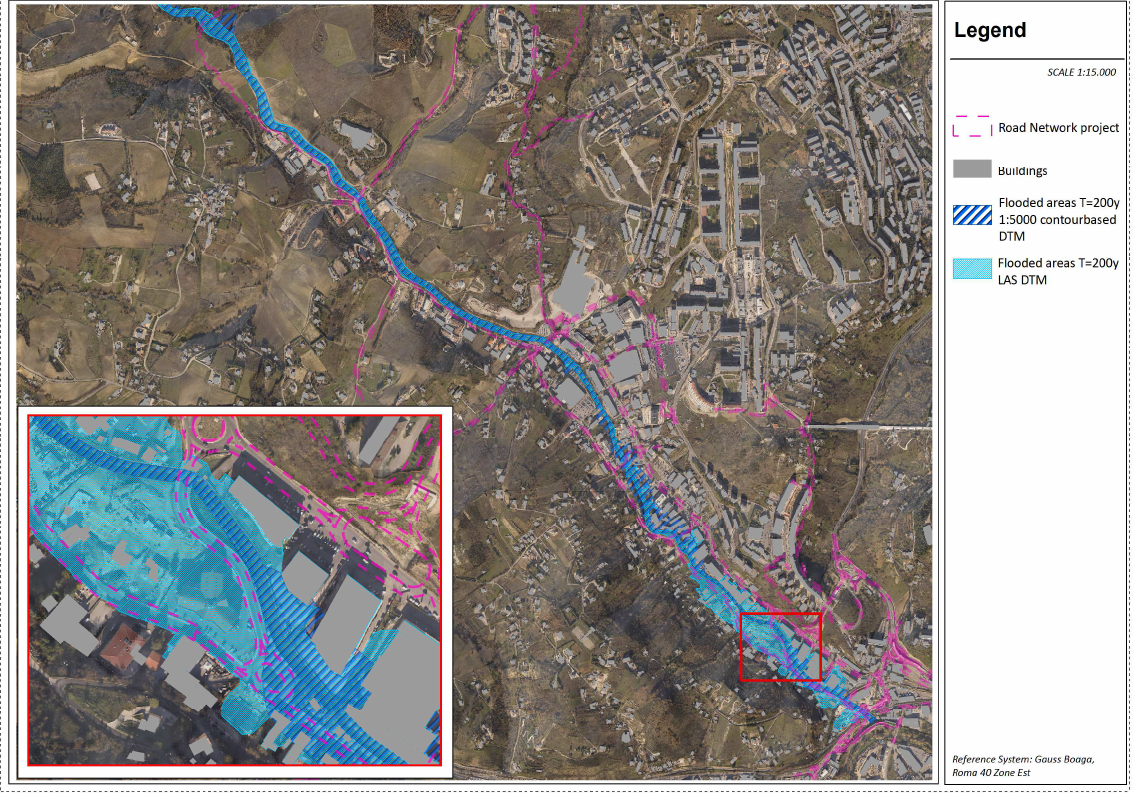
Figure 2. Maximum inundated area for the 200 years return period flow near the Gallitello